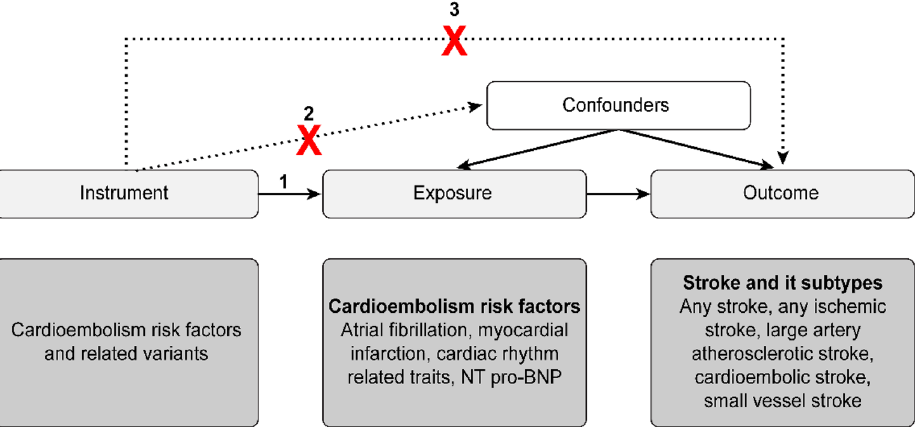
Figure 3. Schematic representation of Mendelian randomization analysis. Broken lines represent potential pleiotropic or direct causal effects between variables that would violate Mendelian randomization assumptions. SNP single-nucleotide polymorphism.